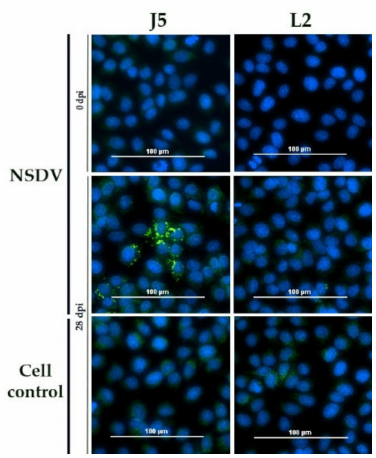
Figure 3. NSDV iIFA: The serum of calf J5 led to a very weak, but distinct staining of NSDV-infected Vero E6, whereas the mock control L2 did not test positive. All other control wells (serum prior to infection, cell controls post infection) were